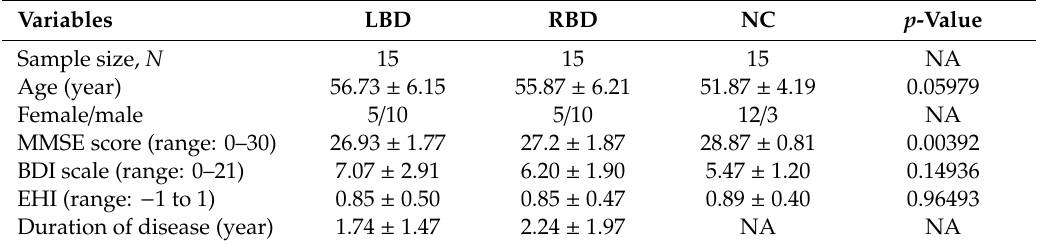
Table 1. Background and neurophysiological characteristics (mean ± std) of left brain damage (LBD), right brain damage (RBD), and normal control (NC) subjects.